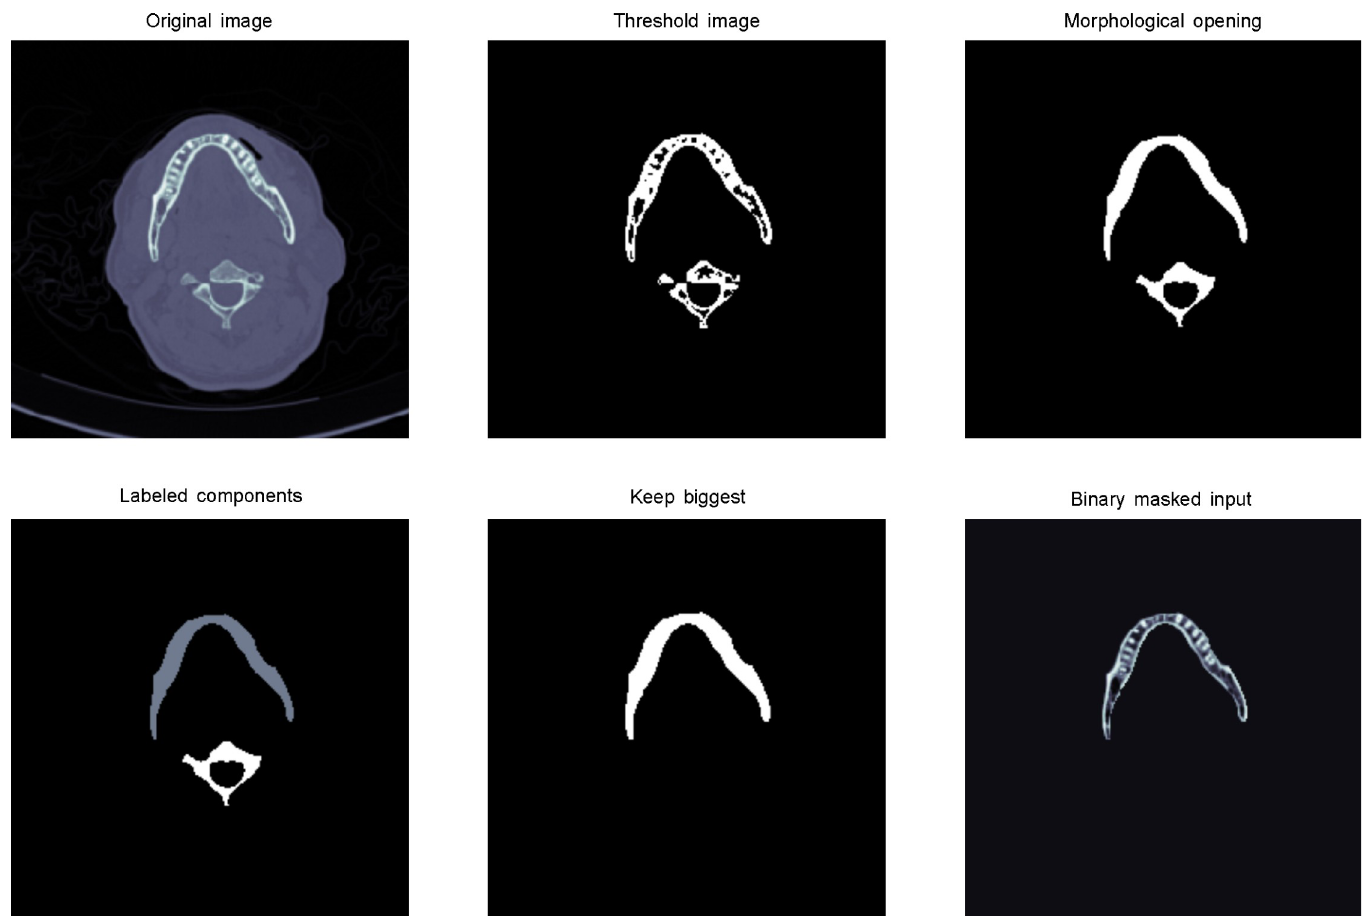
Fig 2. Mandible bone extraction from a raw slice image. (a) Load the original image and crop its center with an image size of 256 × 256. (b) Apply a threshold of 400 to remove tissue and unrelated parts. (c) Perform morphological opening operation, a technique to remove small objects, while maintaining the shape and property of large objects. (d) Label components to identify objects. (e) Retain the large objects in labeled components. (f) Binary masked input to obtain the bone part of mandible slice.